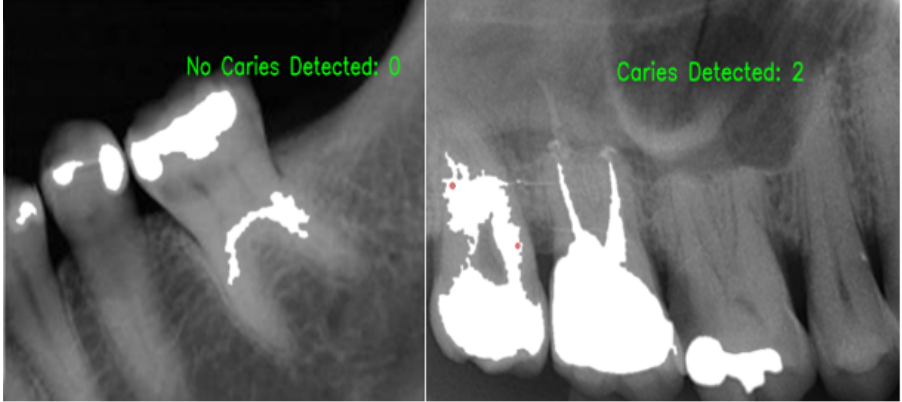
Figure 5. Images of dental caries detected after eliminating false positives through the use of the convexity